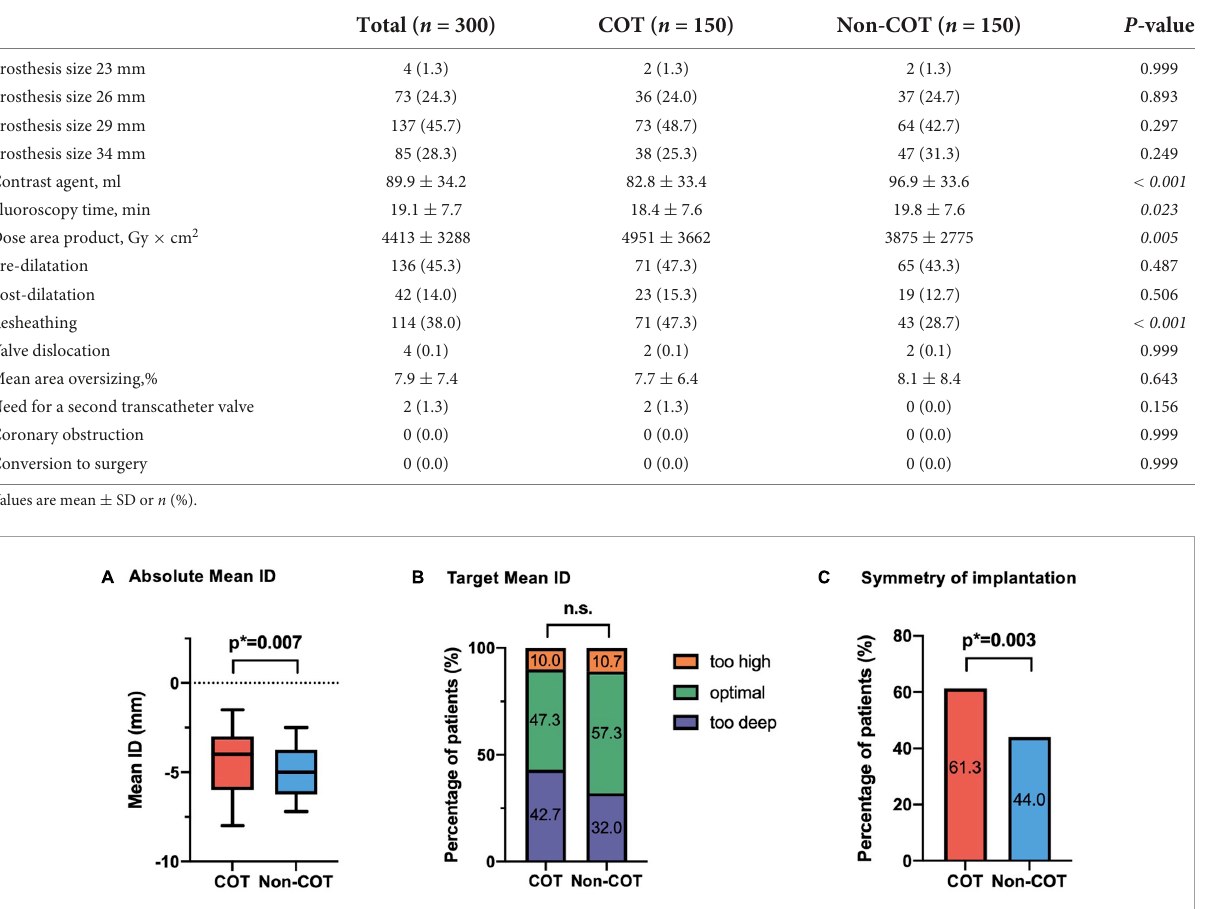
FIGURE4 Impact of COT on implantation depth. (A) There was a significant reduction of final mean ID in the COT cohort (COT –4.2 ± 2.7 mm vs. Non-COT –4.9 ± 2.3 mm; p = 0.007), whereas (B) the target ID of 3 mm in the COT group and 3–5 mm in the Non-COT group was reached similarly often. (C) Reduction in asymmetric valve deployment with a difference of less than 2 mm between NCC and LCC ID could be achieved more often in the COT group (COT 61.3% vs. Non-COT 44.0%; p = 0.003). COT, cusp-overlap technique; ID, implantation